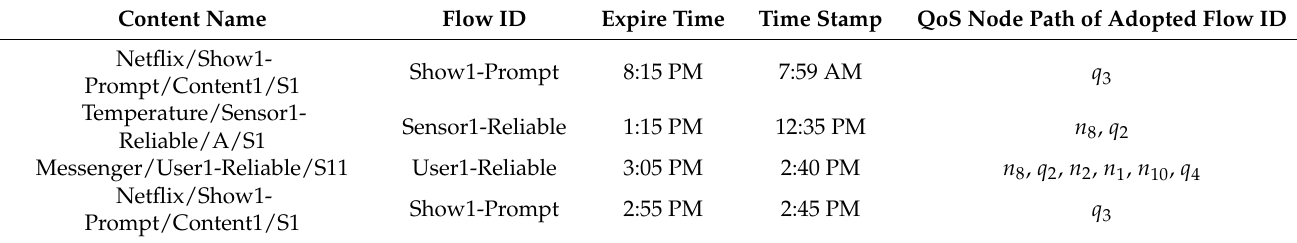
Table 4. QoS Table of q 3